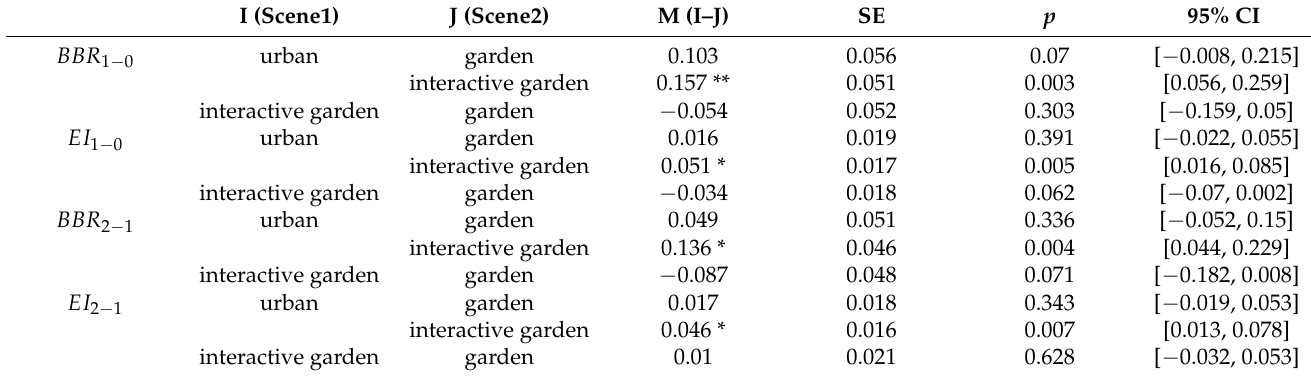
Table A14. Post-test results.